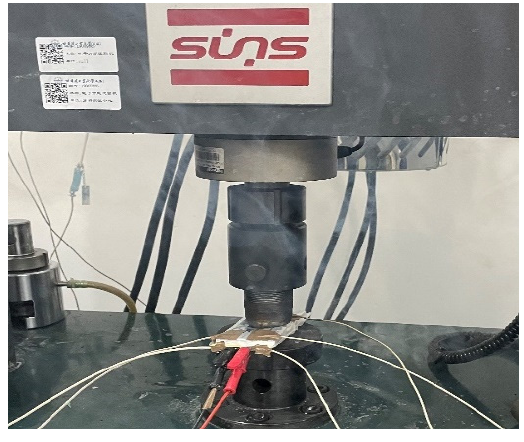
Figure 12. Smoke when the battery fails.